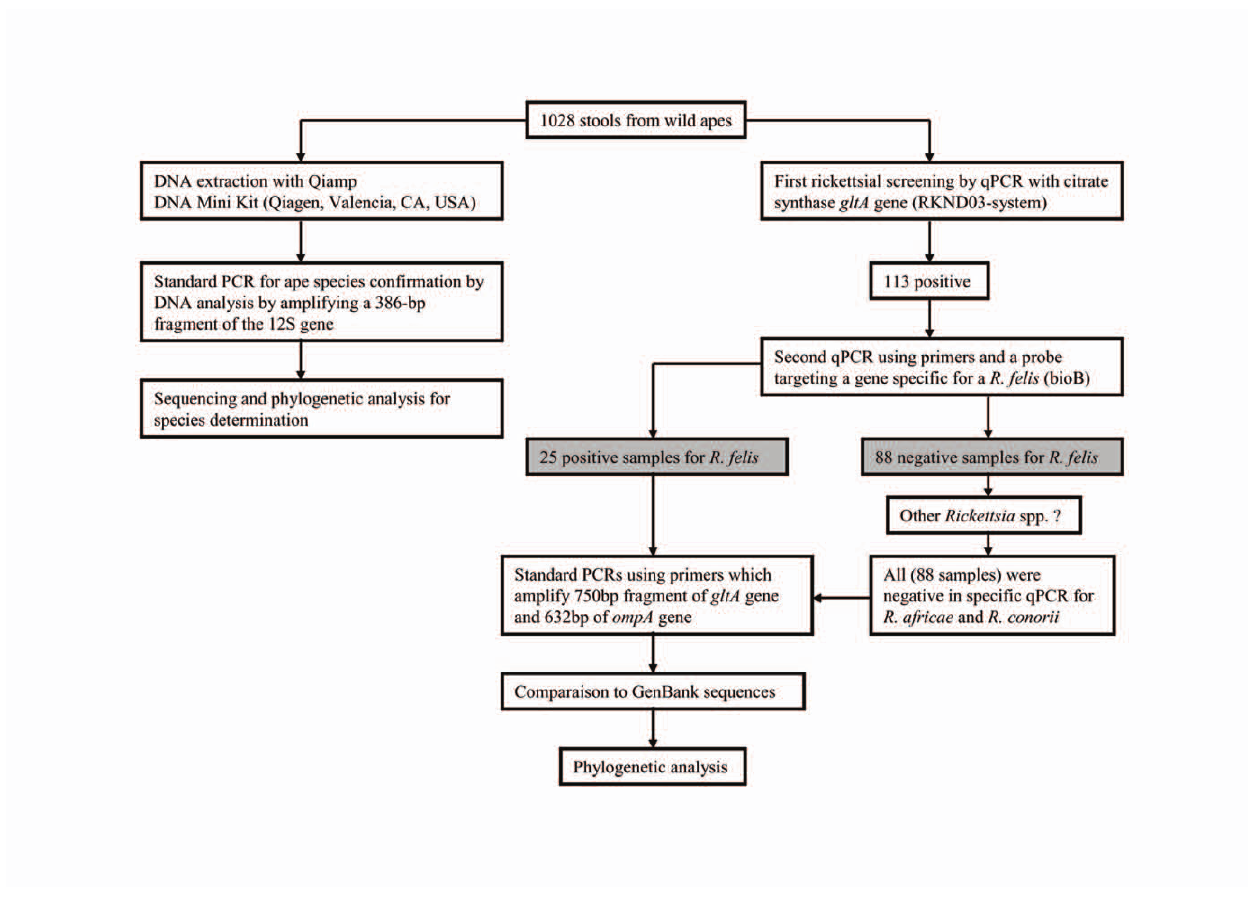
Figure 2. Analysis procedure. doi:10.1371/journal.pone.0054679.g002 (JN315968) from Kenya, and Haemaphysalis sulcata (FJ67737) from Croatia.